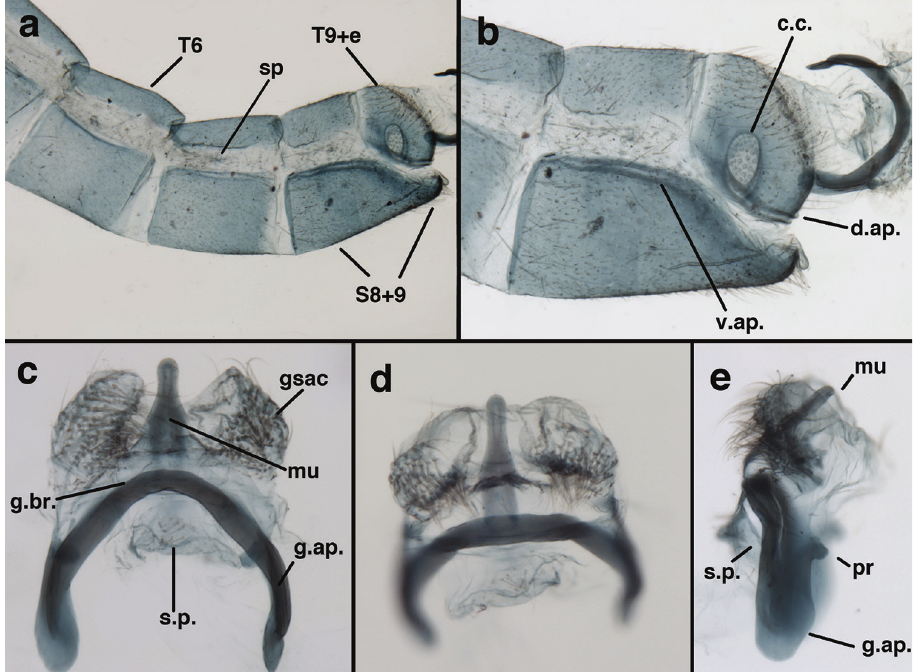
Figure 87. Ungla siderocephala (Navás): Male abdomen and terminalia, ( a ) segments A6–terminus, lateral ( b ) terminalia, lateral ( c ) gonarcus, posterodorsal ( d ) gonarcus, dorsal ( e ) gonarcus, lateral. c.c. callus cerci d.ap. apodeme on ventral margin of T9+ectoproct gsac gonosaccus g.ap. gonarcal apodeme g.br. gonar- cal bridge mu mediuncus pr unarticulated process on frontal margin of gonarcal apodeme sp spiracle S8+9 fused eighth and ninth sternites s.p. setose subanal plate T6 sixth tergite T9+e fused ninth tergite and ectoproct v.ap. apodeme on dorsal margin of S8+9 (all: Lima, Peru,